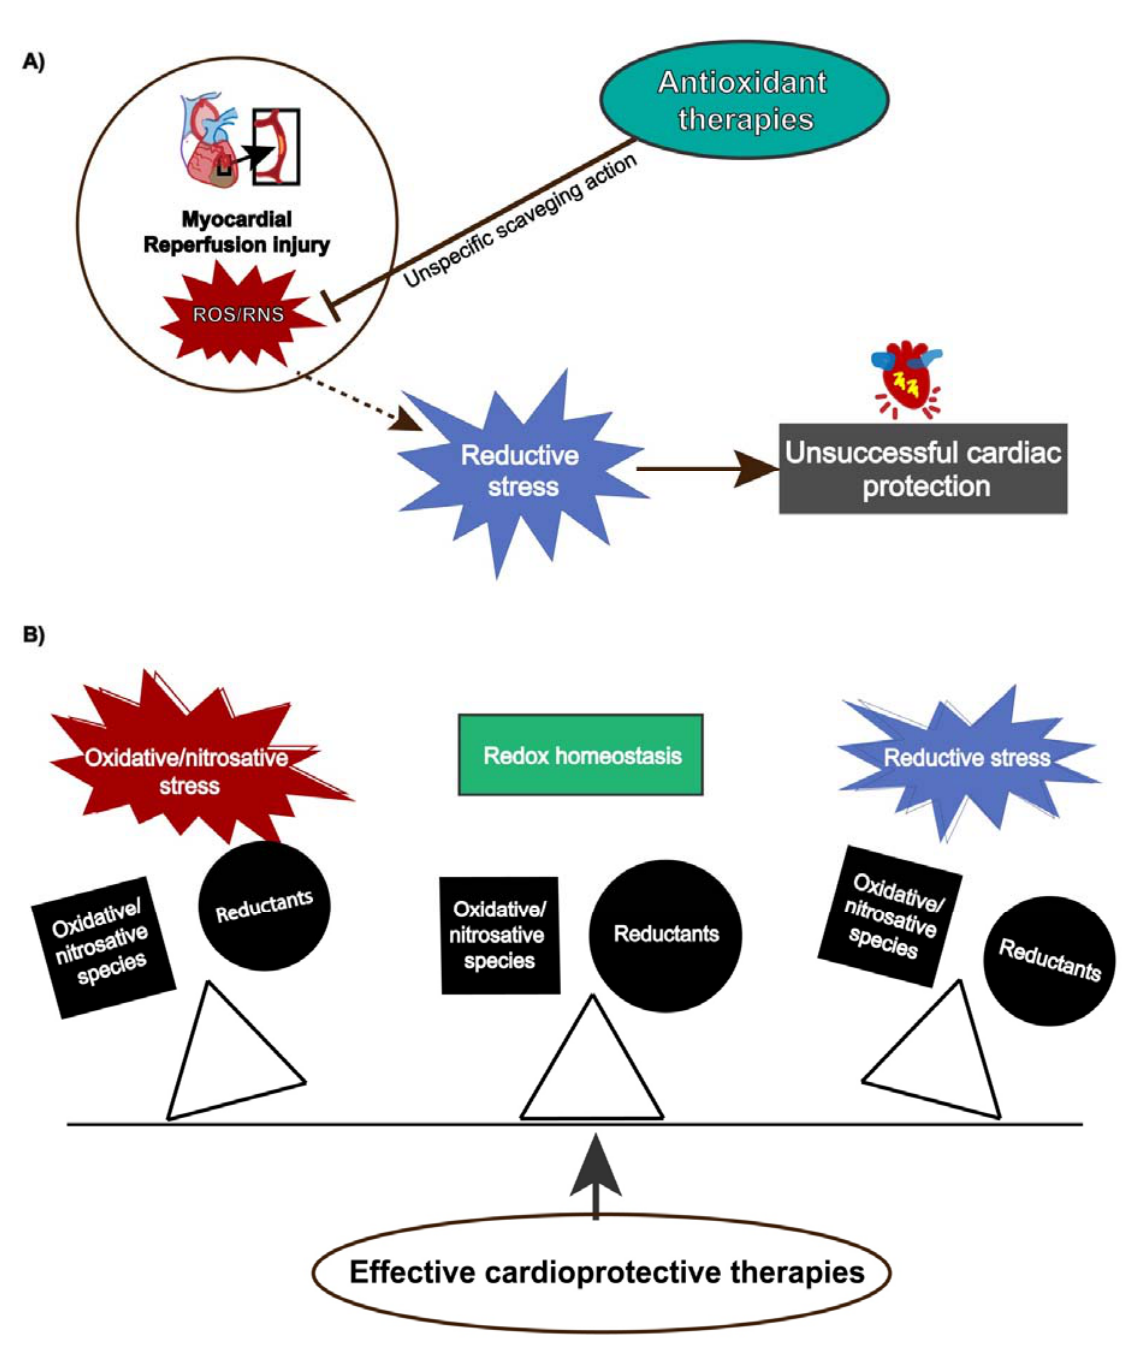
Figure 3. ( A ) Reductive stress induced by antioxidants attenuates cardiac protection. ( B ) Effective cardioprotective strategies preserves redox balance and prevents oxidative/nitrosative or reductive stress.